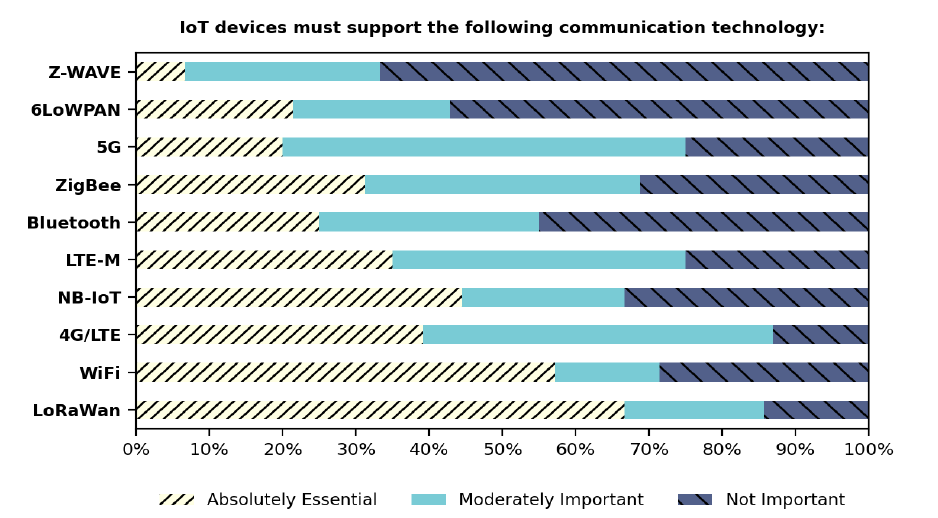
Figure 9. Responses to a survey question about the communication technologies that need to be supported by the IoT middleware